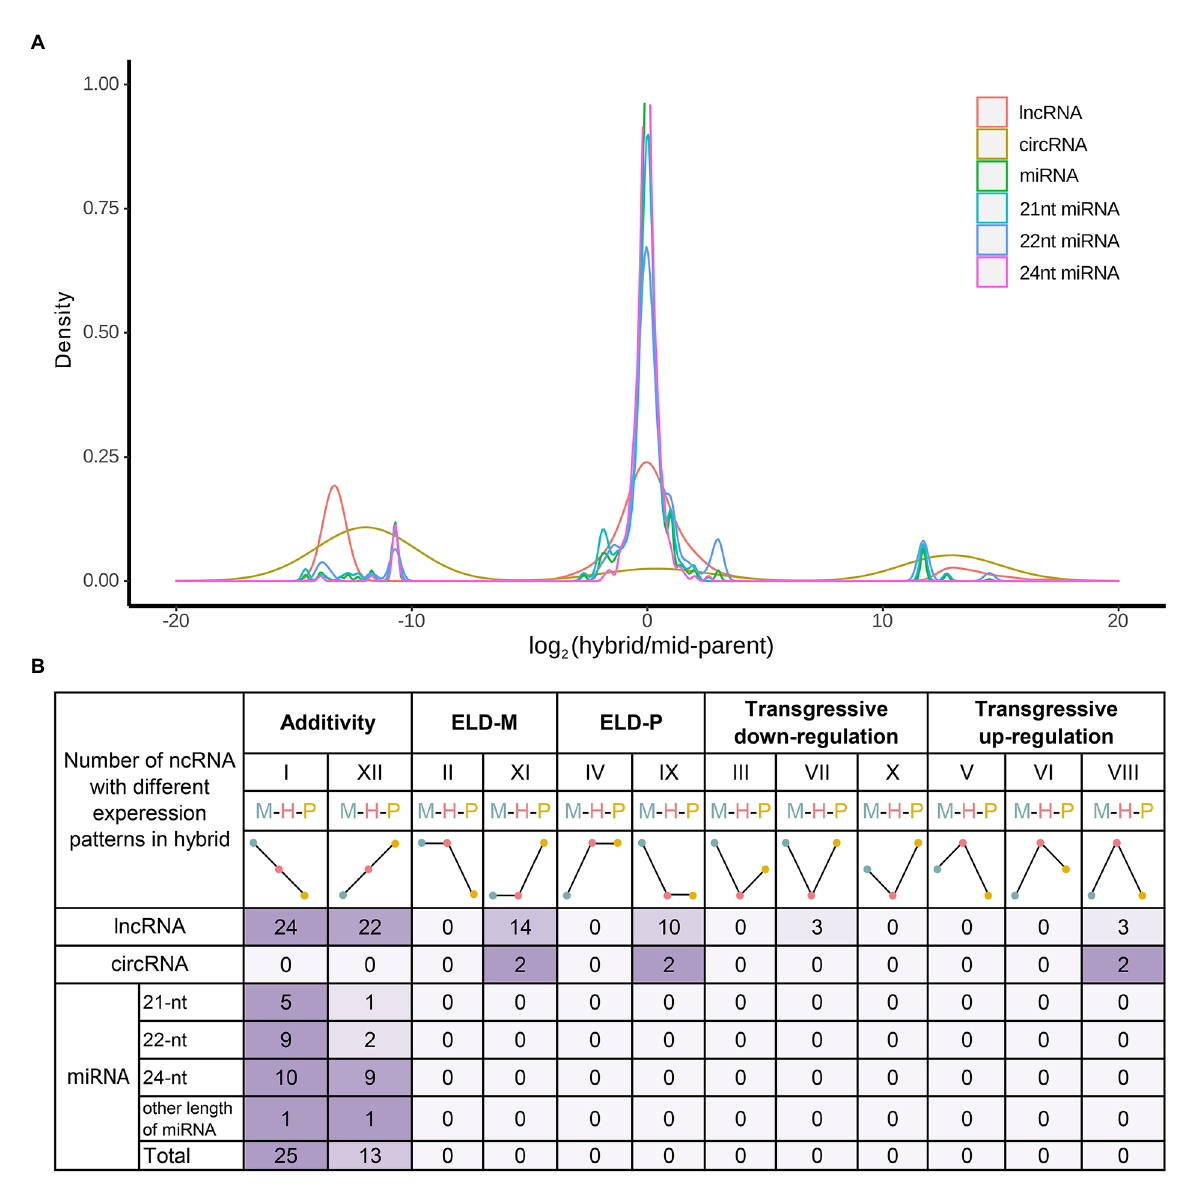
FIGURE 4 Additive and non-additive ncRNAs in hybrids. (A) Ratio distribution of hybrid and MPV in different ncRNAs. (B) Additive and non-additive patterns of ncRNAs. The 12 possible differential expression states in the F1 hybrid relative to its diploid parents. Roman numerals indicate the same categorization as used in Yoo et al.